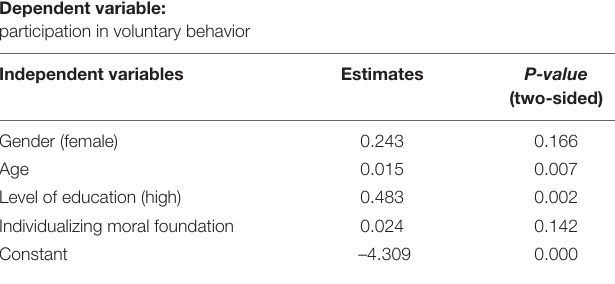
TABLE 8 | Coefficients of the binary logistic regression model predicting voluntary behavior (Study